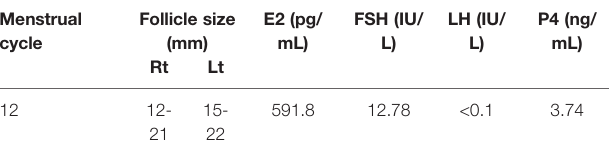
TABLE 3 | Transition in serum steroid hormone concentrations and follicular development during IVF. Menstrual Follicle size cycle